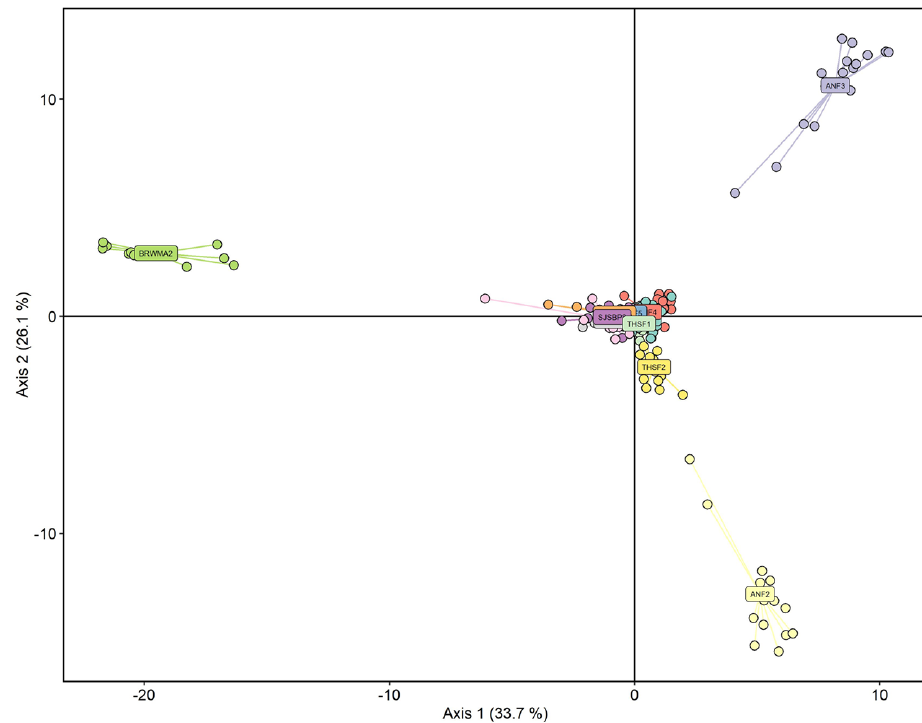
Figure 6. Discriminate analysis of principal components (DAPC) of twelve populations of S. floridana using 20 principal components and eight axes. Populations are shown with different colors, circles represent individuals, and labels are placed on the centroid (average) position for each pop- ulation.